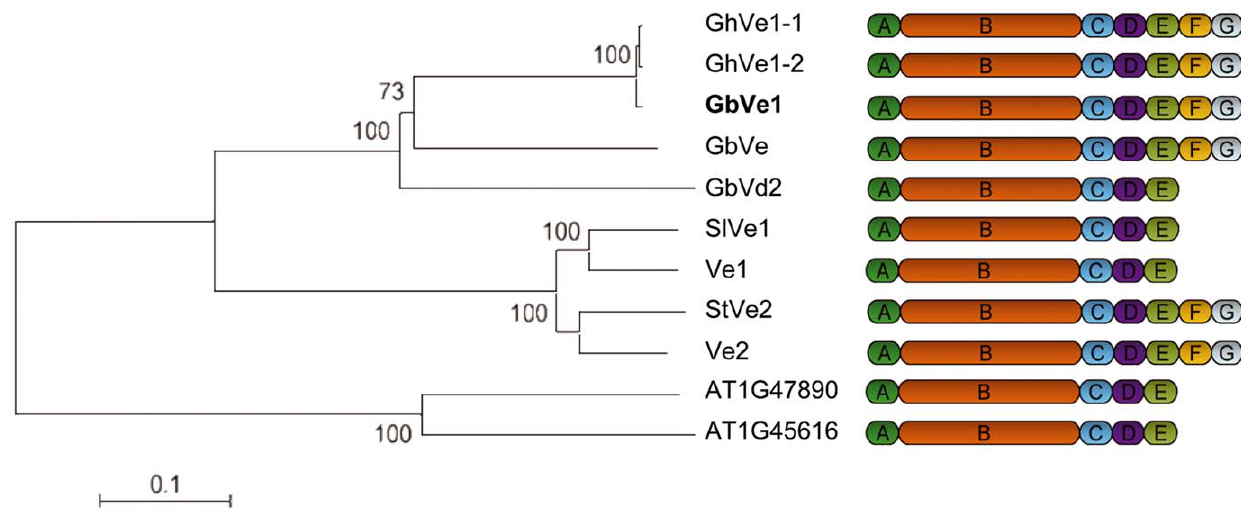
Figure 1. Phylogenetic and structural analysis of Ve-like genes. Domain A is the predicted signal peptide. Domain B that constitutes the main body of the protein is mainly composed of LRRs. The membrane-associated hydrophobic domain D is flanked by a neutral/acidic amino acids rich domain C and by a neutral/basic amino acids rich domain E. Domain F contains a PEST sequence, while domain G contains an endocytosis signal. The detail information about the sequences and domains of GbVe1 protein are shown in Figure S1. Other genes could be found in the GenBank database using following accession numbers: GbVe (EU855795), GbVd2 (GU299534), SlVe1 (AY262016), StVe (AY311527), Ve1 (AF272367), Ve2 (AF365929), and the two A. thaliana genes, AT1G47890 and AT1G45616, could be found in www.arabidopsis.org.